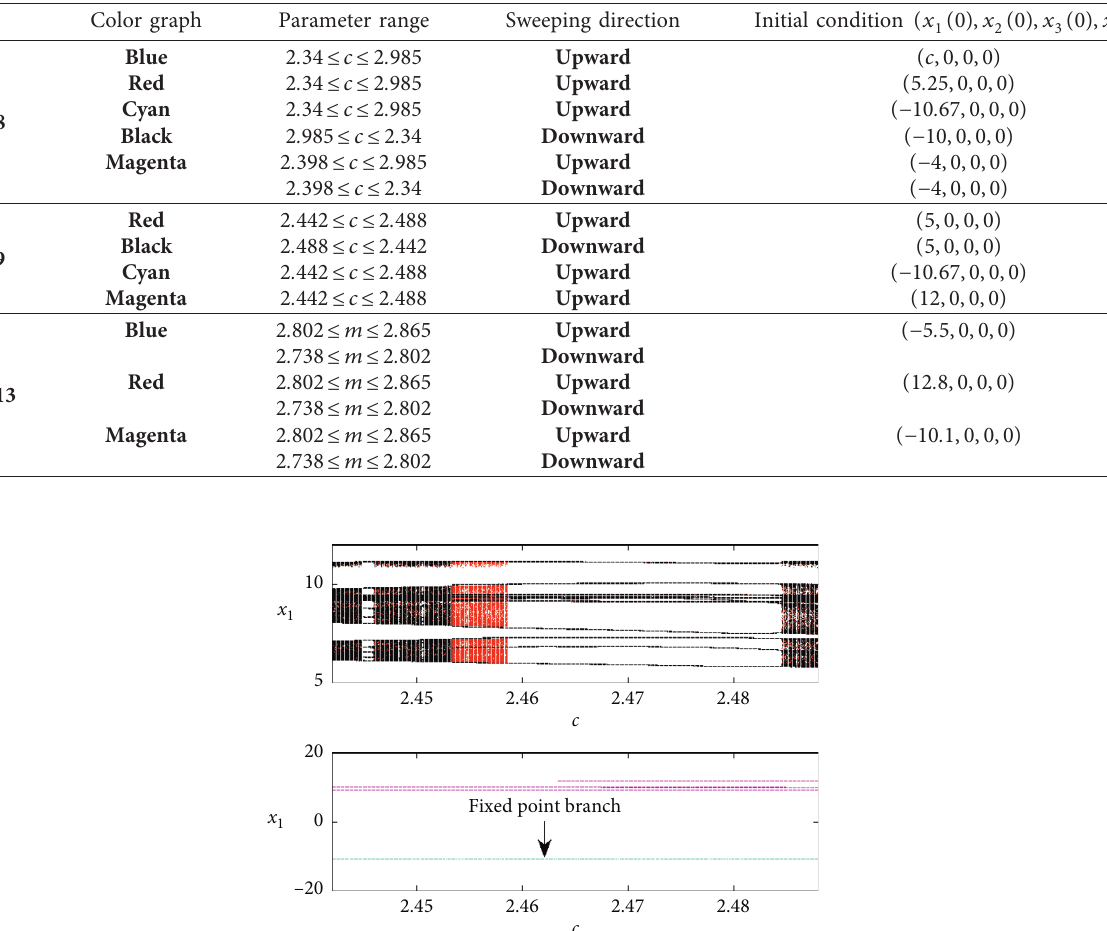
Figure 9: Enlargement of bifurcation diagram of Figure 8 plotted in the range 2 . 442 ≤ c ≤ 2 . 488 showing the region in which the system exhibits multiple coexisting attractors. The system parameters are the same as the one of Figure